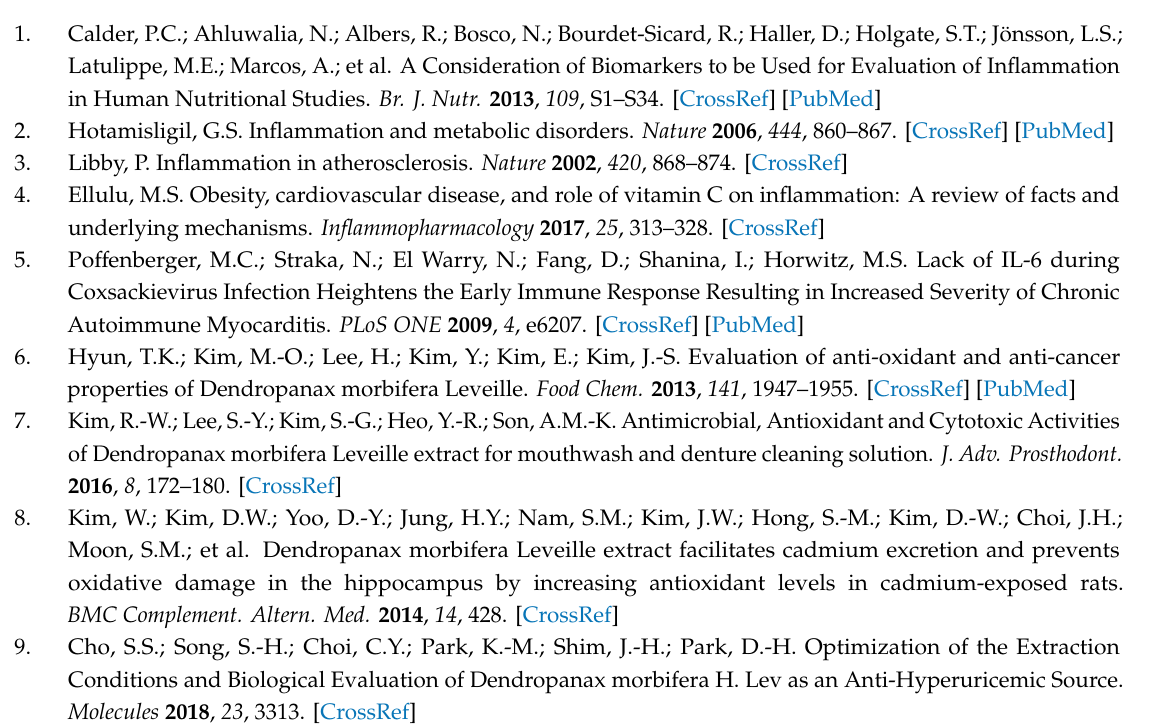
Figure S1: Relationship between α - (a) or β -amyrin (b) and PGE 2 or proinflammatory cytokines. Correlations are presented as Pearson´s correlation coe ffi cients (r2); Figure S2: Relationship between chlorogenic acid and inflammatory mediators (a) or proinflammatory cytokines (b). Correlations are presented as Pearson´s correlation coe ffi cients (r2); Figure S4: Relationship between p-coumaric acid and inflammatory mediators (a) or proinflammatory cytokines (b). Correlations are presented as Pearson´s correlation coe ffi cients (r2); Figure S5: Relationship between Rutin and inflammatory mediators (a) or proinflammatory cytokines (b). Correlations are presented as Pearson´s correlation coe ffi cients (r2); Table S1: The correlation r2 and p-values between flavonoid compounds and proinflammatory mediators or